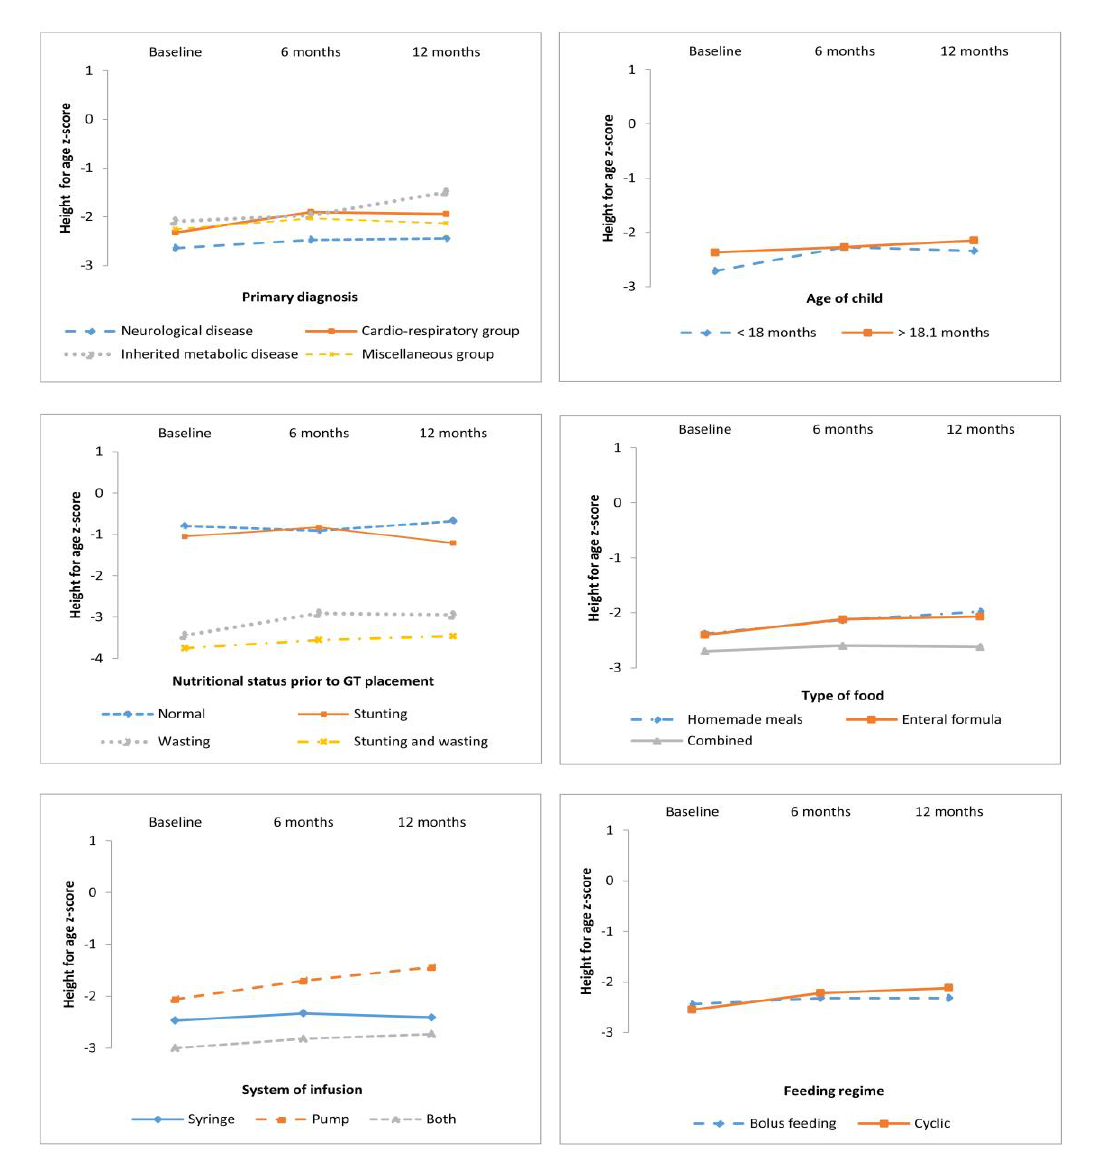
Figure 2. Height-for-age z-score according to analyzed variables.